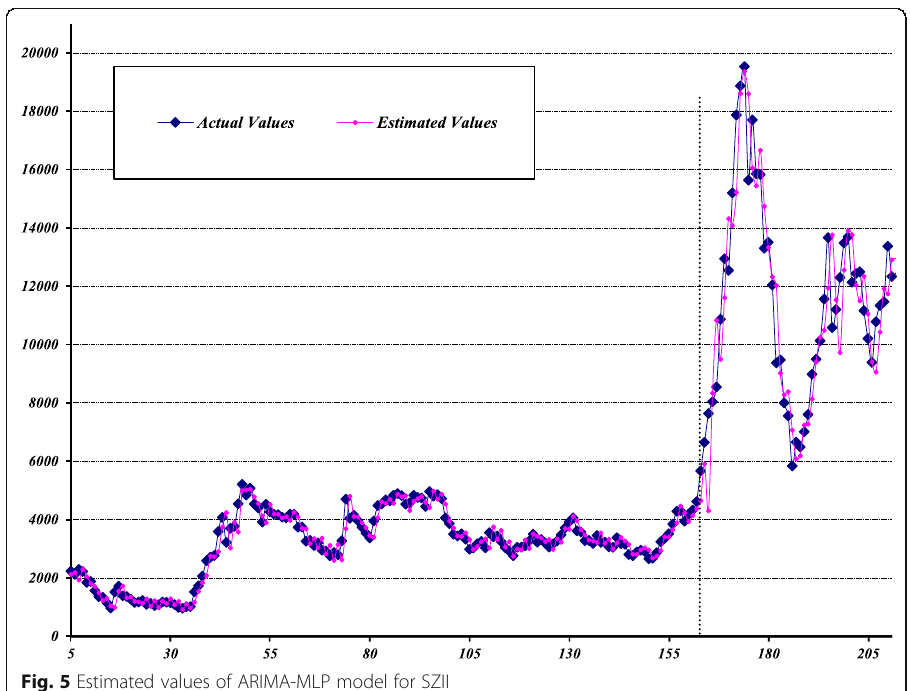
Fig. 5 Estimated values of ARIMA-MLP model for